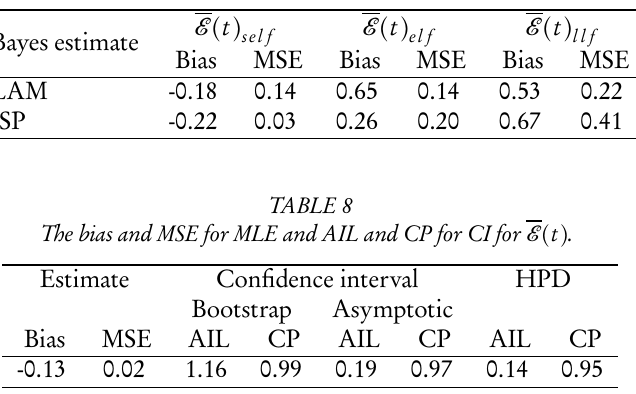
The Lindley approximation and importance sampling procedure for (cid:69) ( t ) .